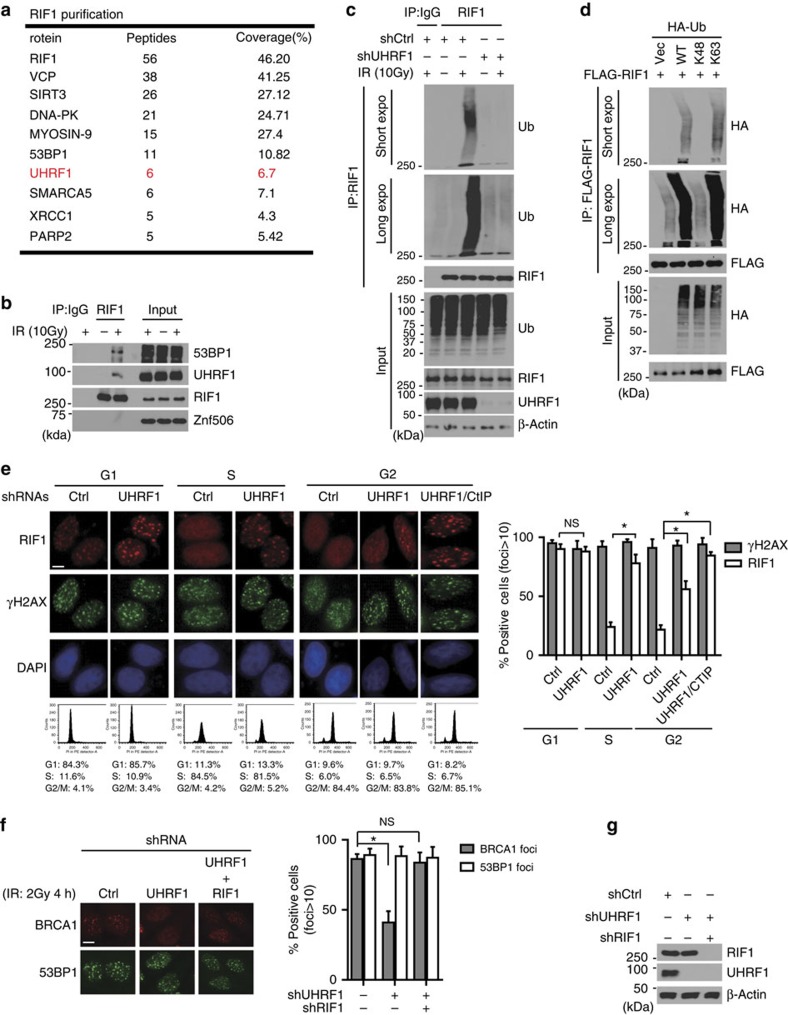
UHRF1 ubiquitinates RIF1.(a) Tandem affinity purification of RIF1 was performed using antibody against endogenous RIF1. The major hits from mass spectrometry analysis were shown in the table. (b) Endogenous Co-IP between UHRF1 and RIF1 in HeLa cells was performed. 53BP1 and Znf 506 were blotted as positive and negative control respectively. (c) UHRF1 ubiquitinates RIF1 in vivo. HeLa cells stably expressing control or UHRF1 shRNA were irradiated (10 Gy), and RIF1 ubiquitination was then examined under denaturing conditions 1 h after IR (see Methods). (d) UHRF1-mediated K63-linked polyubiquitination of RIF1 in vivo. HEK 293T cells were transfected with the indicated constructs. RIF1 ubiquitination was examined as in c. (e) UHRF1 promotes removal of RIF1 from DSB sites in S phase. HeLa cells stably expressing the indicated shRNAs were synchronized and irradiated. RIF1 and H2AX foci formation were then examined. Left: Representative micrographs. Lower panels: representative cell cycle profiles of synchronized cells. Right: Quantitation of the positive cells (foci>10 per cell) as indicated. For each sample, 600 randomly selected cells were counted. Data presented as mean±s.d. of three biological triplicates. RIF1 foci Positive cell percentage compared with control group. *P<0.05. NS: no siginficant difference, Scale bar, 10 μm. (f) HeLa cells expressing the indicated shRNAs were irradiated and immunostained with antibodies as indicated. Left: representative micrographs. Right: quantification of BRCA1 and 53BP1 foci positive cells (foci>10 per cell). For each sample, randomly selected 500 cells were counted. Data presented as mean±s.d. of three biological triplicates. Positive cell percentage compared with control group. *P<0.05. NS: no siginficant difference, Scale bar, 10 μm. (g) Immunoblot with indicated antibodies for the cell lysates in f.